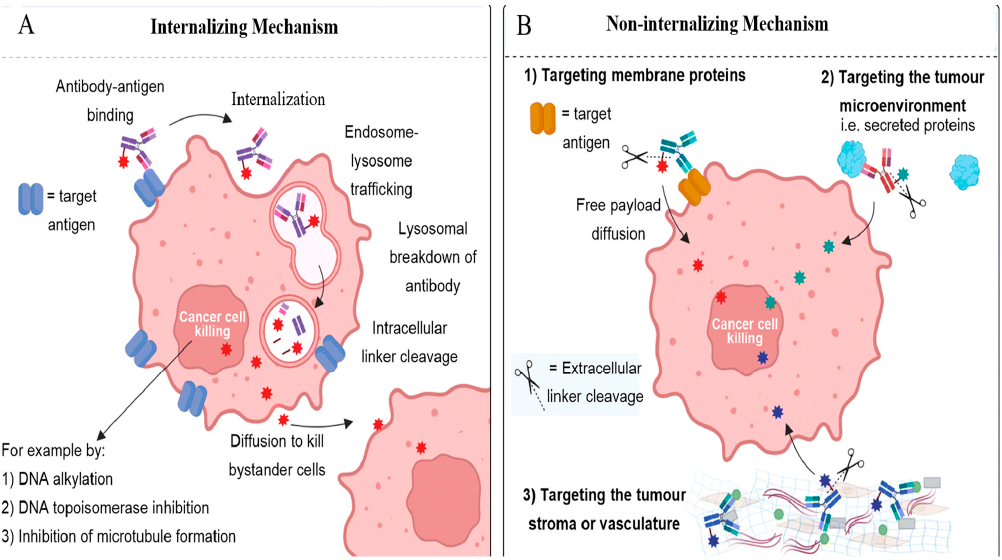
Figure 4. Internalizing versus non-internalizing mechanism. Adapted from in modi fi ed form [8].